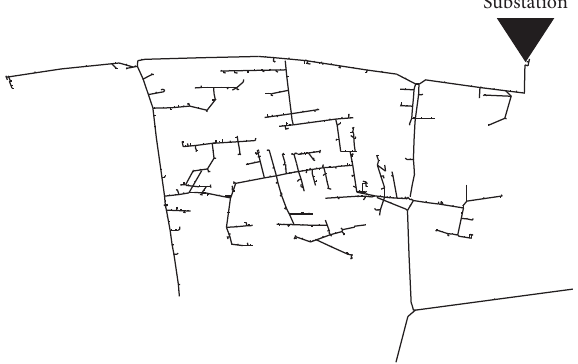
Figure 23: Network confguration of feeder no. 1.